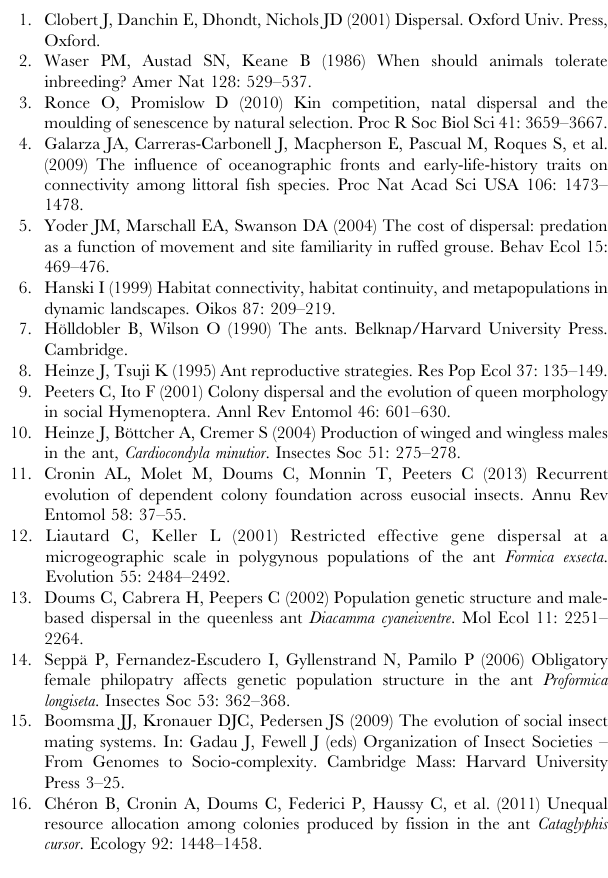
Figure S2 Relationship between geographical distance and mitochondrial genetic differentiation between nests for the transect, estimated as F ST /(1-F ST ). The correlation is highly significant (R= 0.47, p , 0.001). Table S1 Mantel tests analysed and statistics for genotyped nests from nuclear data (microsatellites). All results were non significant. See Figure S1 for details of transects used to test possible correlation of genetic divergence and geographic distance at a local